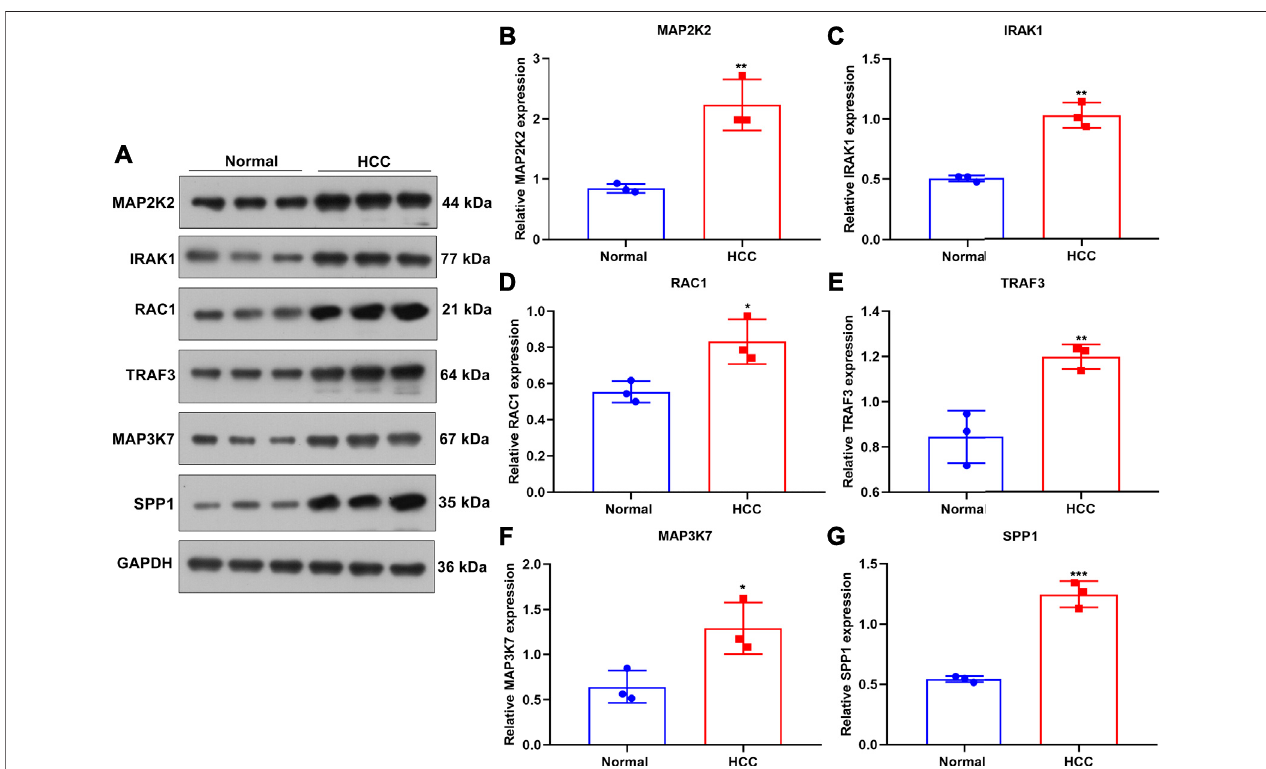
FIGURE 8 | Veri fi cation of the expression of genes in the TLR-based signature in HCC and normal tissue specimens. (A) Western blot for detecting MAP2K2, IRAK1, RAC1, TRAF, and MAP3K7 proteins in three paired HCC and normal tissues. (B – G) Quanti fi cation of the expression of (B) MAP2K2, (C) IRAK1, (D) RAC1, (E) TRAF, (F) MAP3K7,and (G) SPP1proteinsinthreepairedHCCandnormaltissues.ComparisonsbetweengroupswereevaluatedwithStudent ’ sttests.* p < 0.05;** p < 0.01; *** p < 0.001.